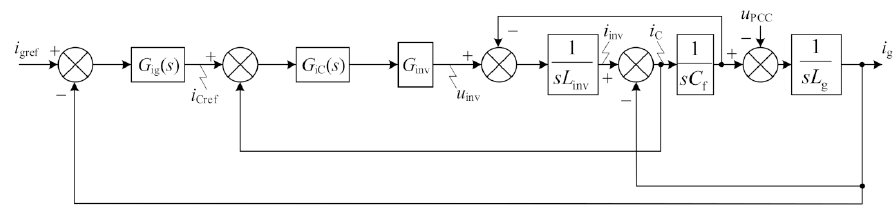
Figure 2. Structure diagram of the control system for single-phase voltage source LCL-type converter. According to Figure 2, the expression of converter output voltage u inv